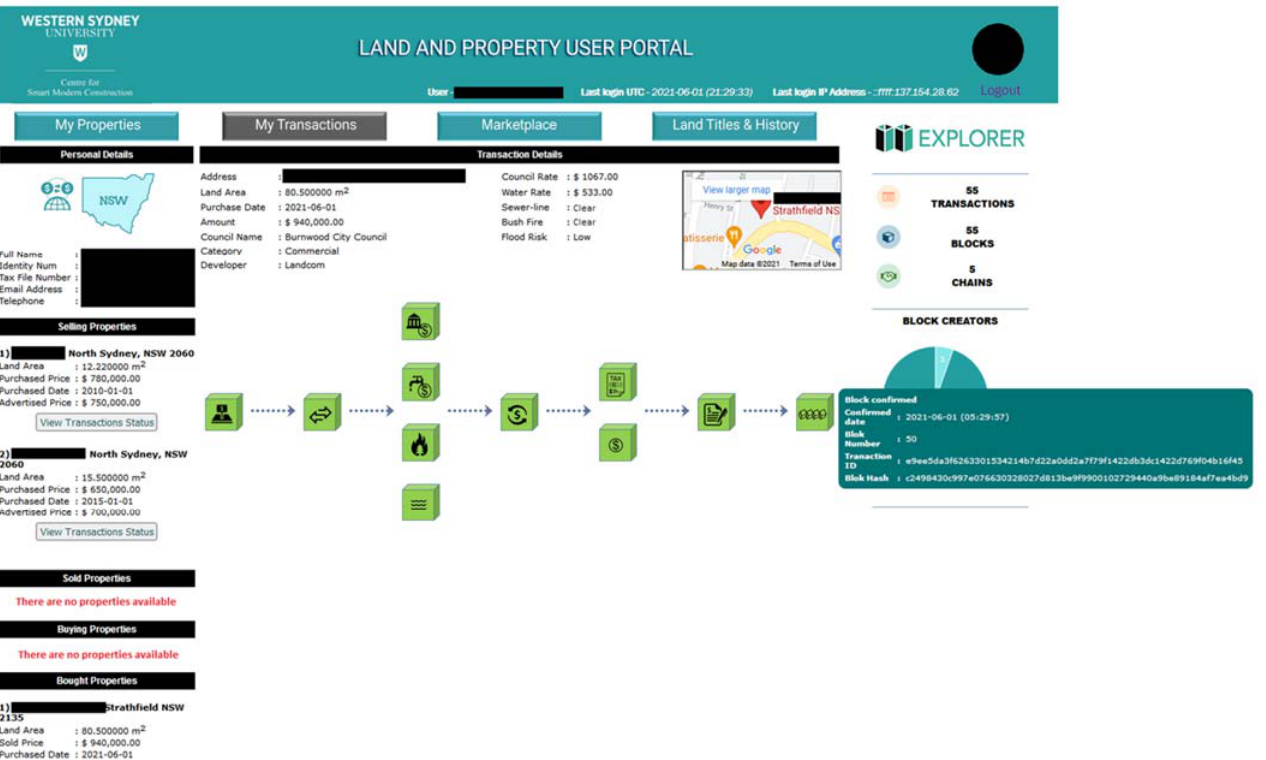
Figure 11. Transaction status view for a property buyer.